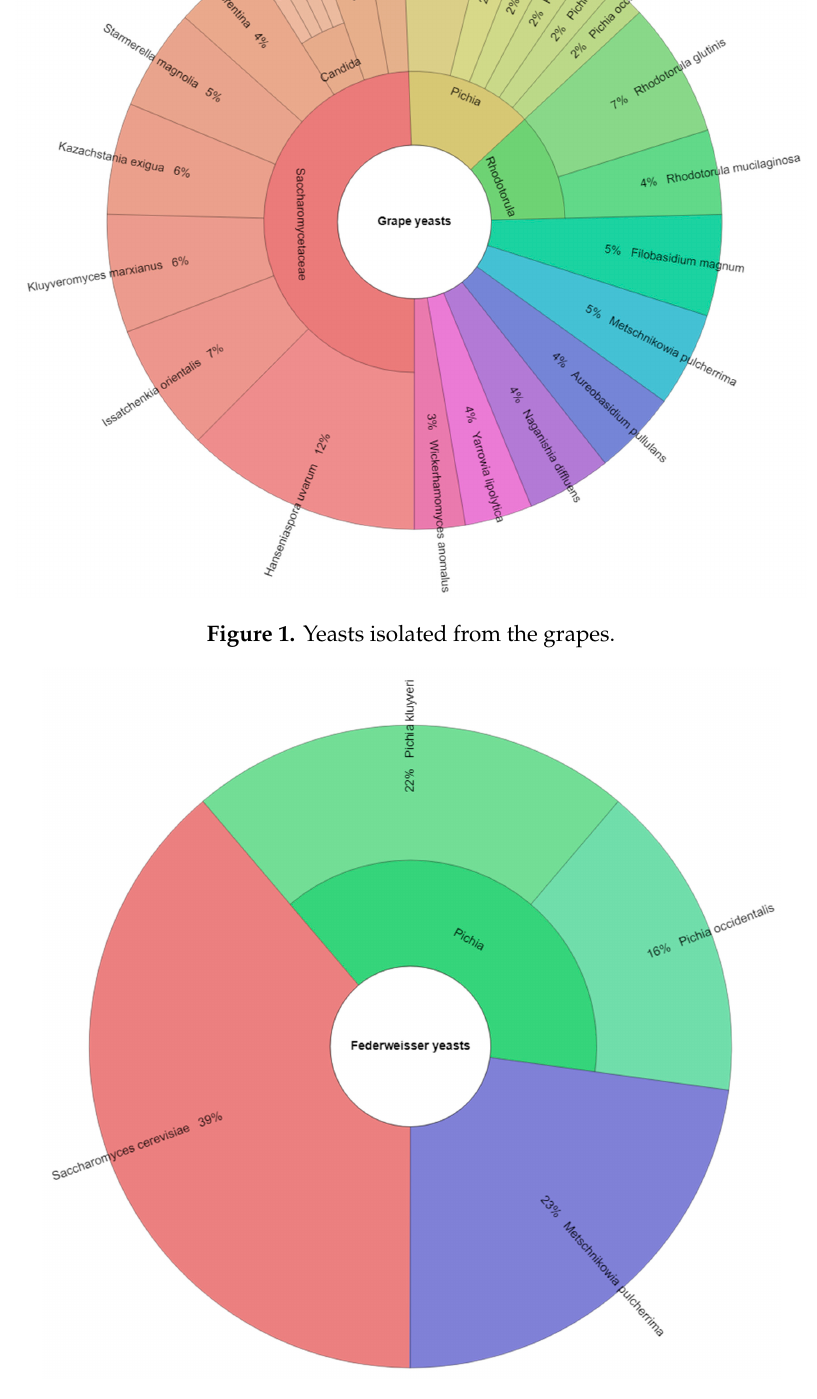
Figure 2. Yeasts isolated from the “federweisser”.